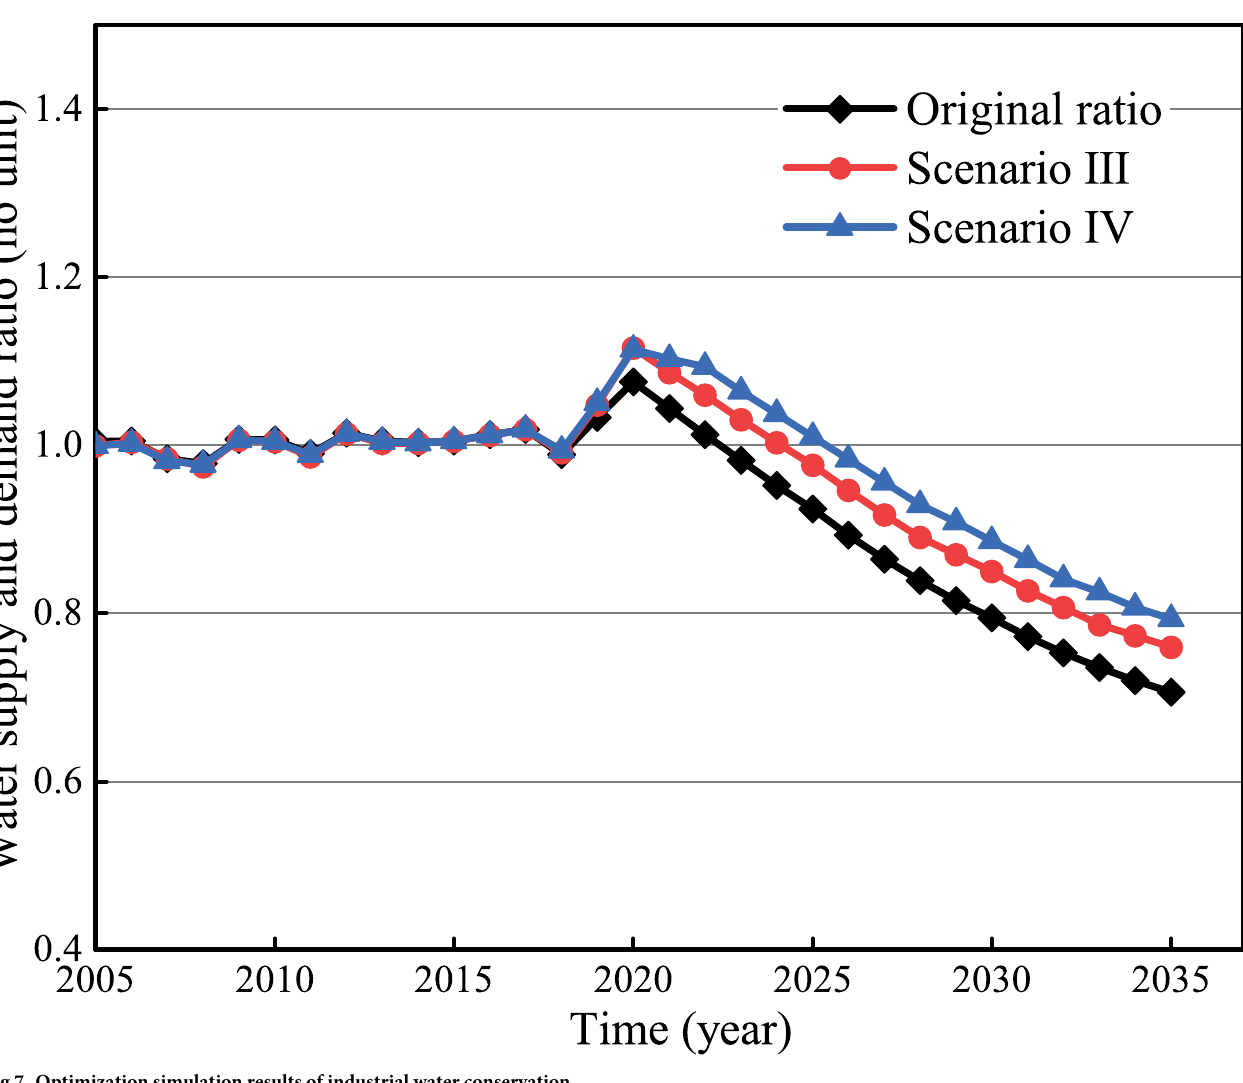
Fig 7. Optimization simulation results of industrial water